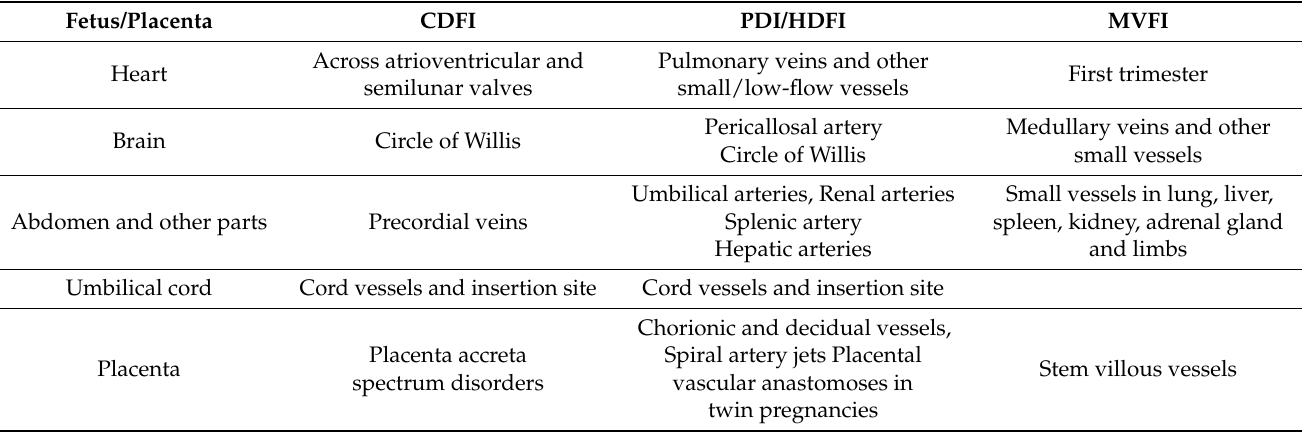
Table 2. Various CFI modes in the assessment of fetal and placental